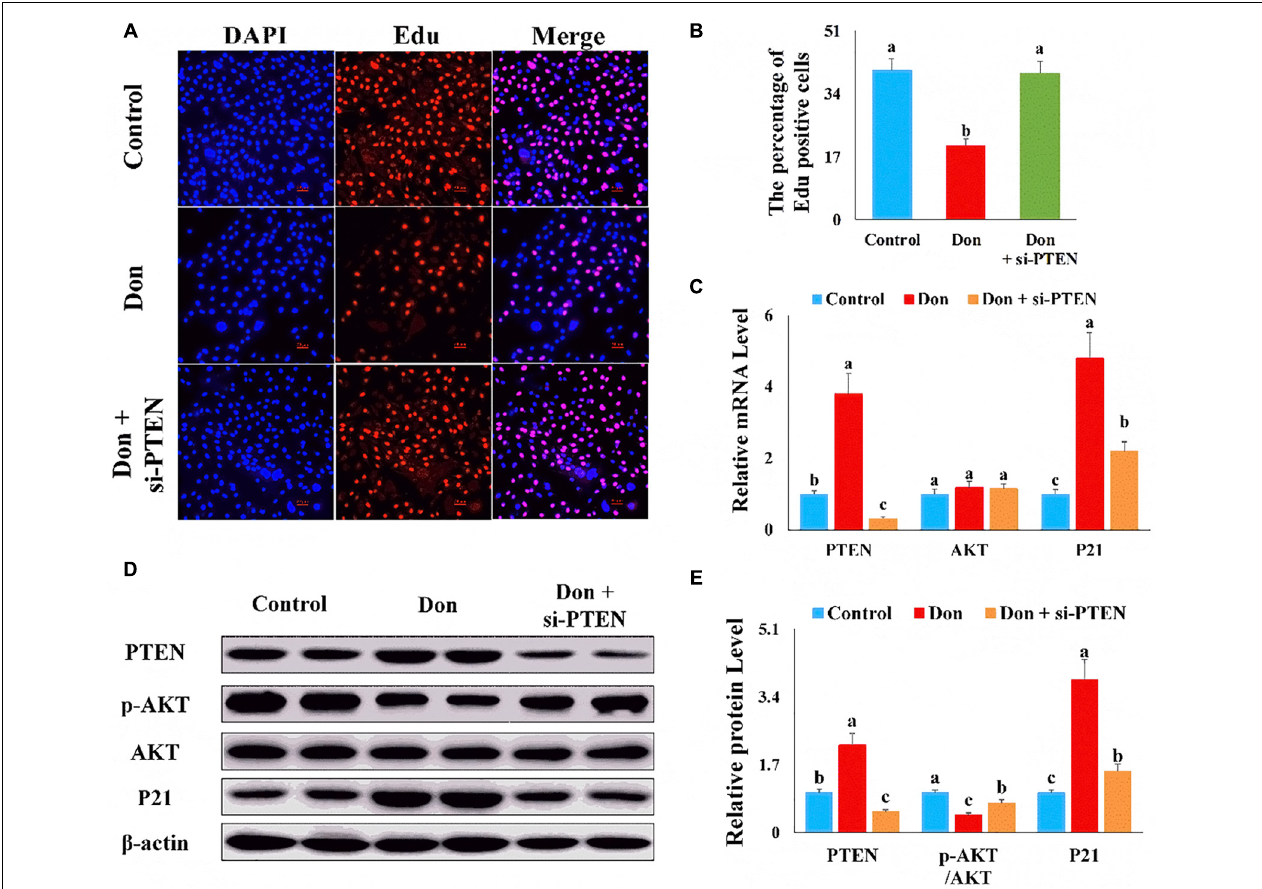
FIGURE 7 | The proliferation inhibition of Don on intestinal epithelial cells relied on PTEN. (A) Representative images of the EdU staining for proliferating intestinal epithelial cells are shown. The cell nucleus was stained with DAPI, blue. Proliferating intestinal epithelial cells were labeled with EdU fluorescent dye (red). (B) The quantitative result of (A) . (C) qPCR results indicated that the proliferation inhibition of Don on intestinal epithelial cells relied on PTEN. (D) Western blot results showed the proliferation inhibition of Don on intestinal epithelial cells relied on PTEN. (E) The relative protein levels obtained by WB band gray scanning. The results were presented as mean ± SEM of triplicate independent experiments for each group. Bars with different letters indicate they are significantly different ( p < 0.05). In (A) , magnification = × 100; the scale bar on the photomicrographs represents 100 µ m. Don, IPEC-J2 cells were exposed to 1.6 µ g/ml Don for 12 h. Don + si-PTEN, IPEC-J2 cells were transfected with 80 nM si-PTEN mimics for 24 h, then exposed to 1.6 µ g/ml Don for 12